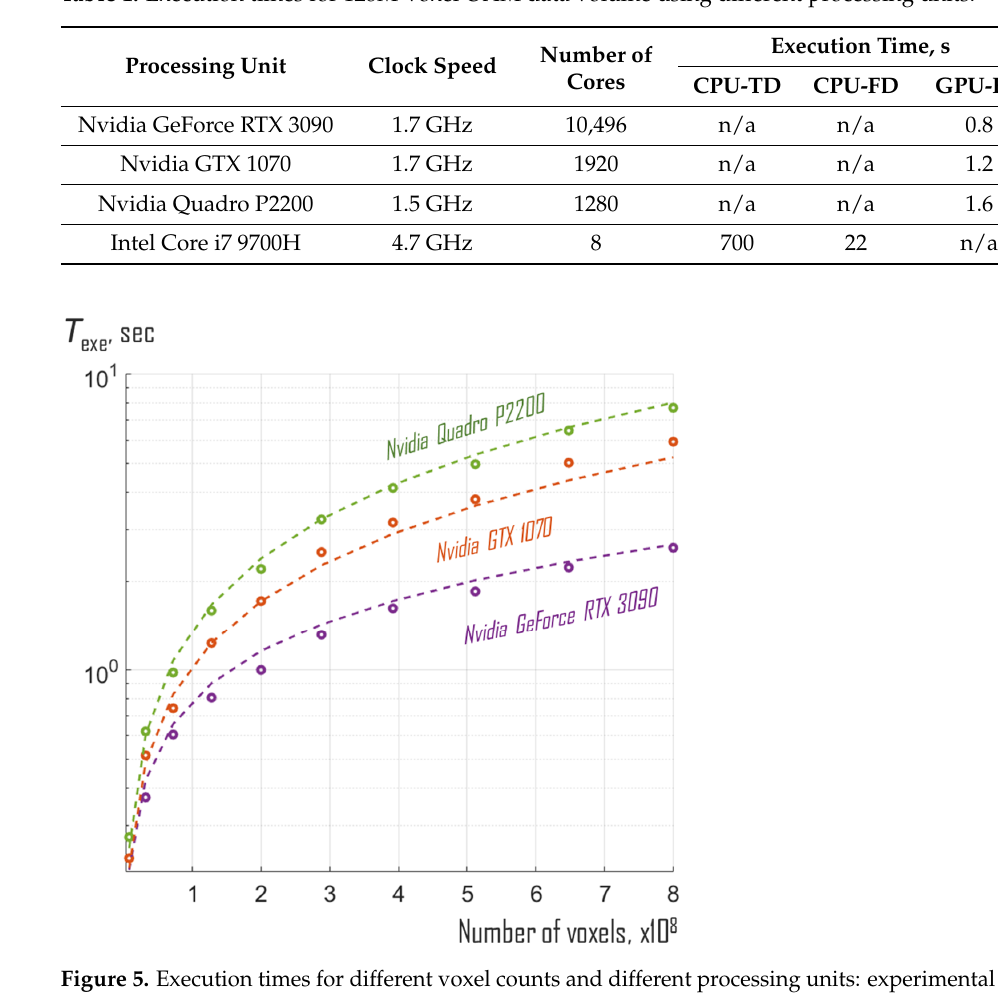
Figure 4. Execution times for different algorithms and different data volumes. Table 1. Execution times for 128M-voxel OAM data volume using different processing units.